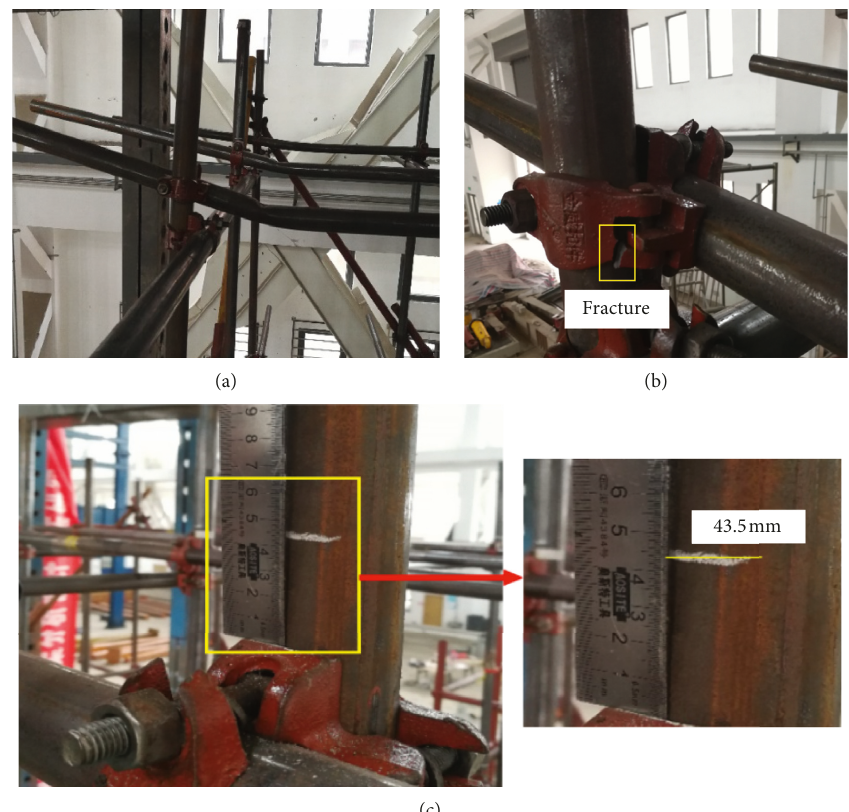
Figure 14: Failure situations of Model 1. (a) Deformation of horizontal rods. (b) Failure of top fasteners. (c) Slippage of fasteners.